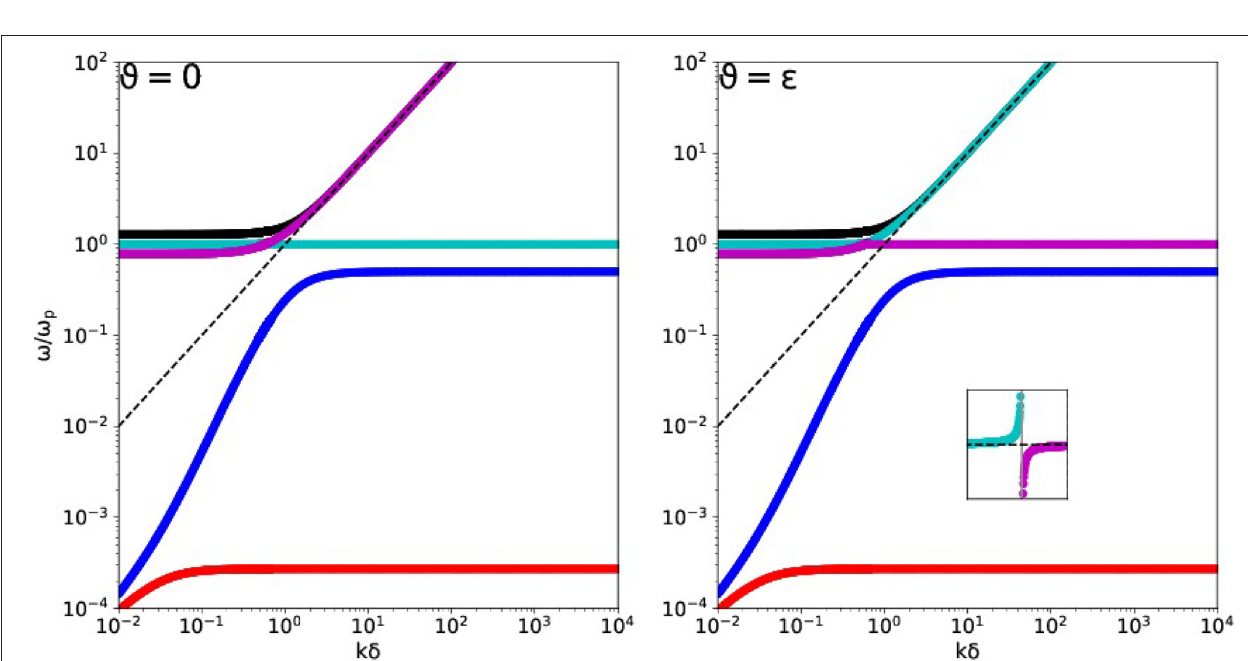
FIGURE 3 | Dispersion diagram for a hydrogen ion-electron plasma at E propagation. The former shows avoided crossings (see inset). The dashed black line corresponds to light speed behavior.